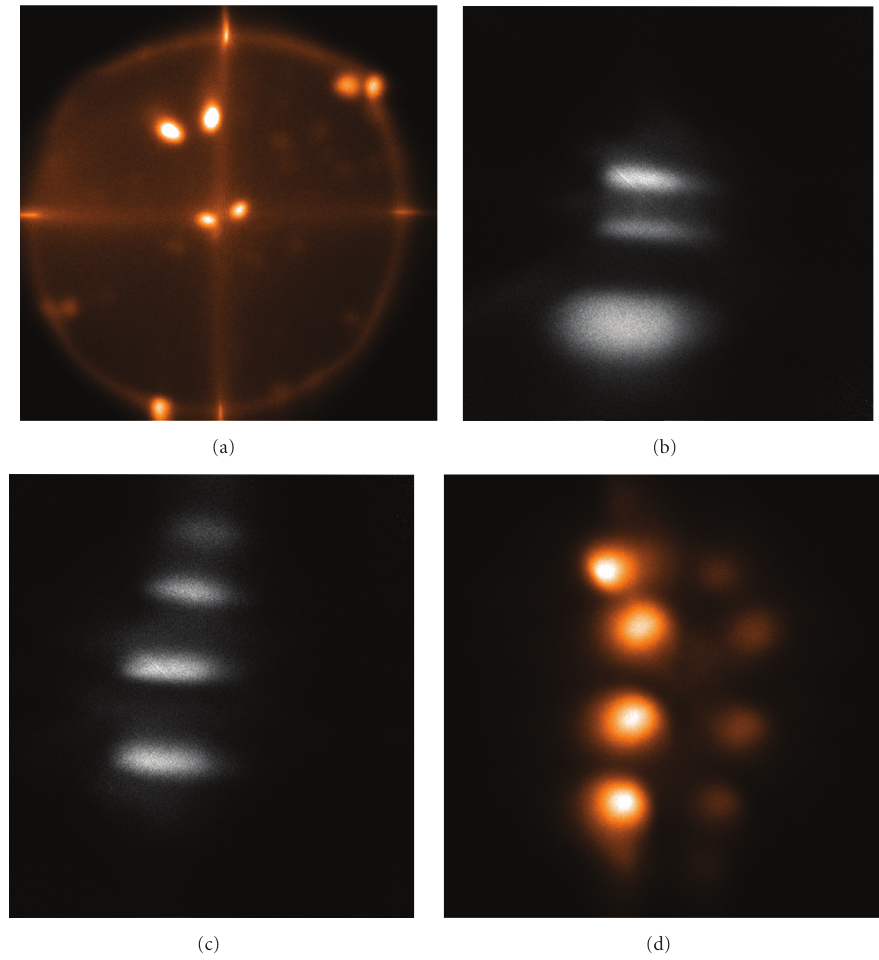
Figure 6: The di ff erent modes of MPPP operation. (a) One-color photopolarimetric mode with two images of each object in wide field. (b) Spectroscopic mode with low-resolution spectrum of object, along with ones of comparison star and the region of the sky used for calibration. (c) Spectropolarimetric with object spectra in four di ff erent polarizations. (d) Multicolor photopolarimetric mode with four images of object in two